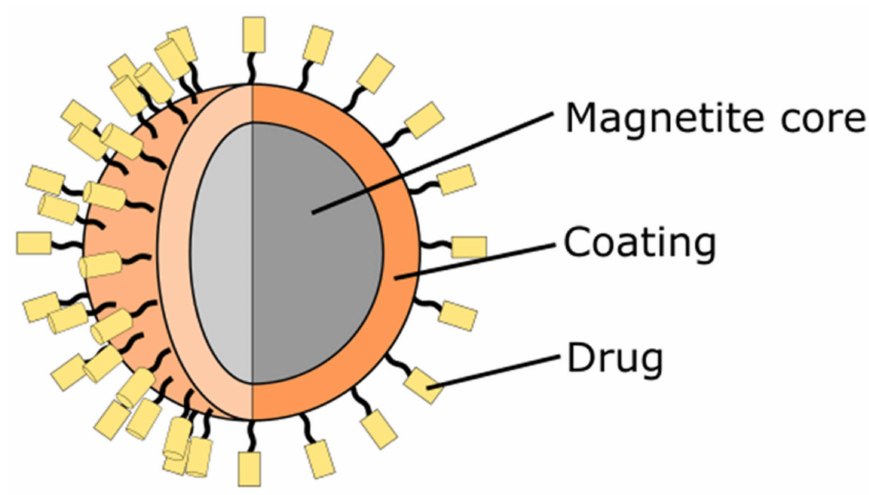
Figure 1. Schematic representation of a therapeutic magnetite-based nanoparticle. In typical magnetite-based nanoparticle, core of the nanoparticle is made of magnetite. The core is covered with a coating substance. On the surface, therapeutic load is